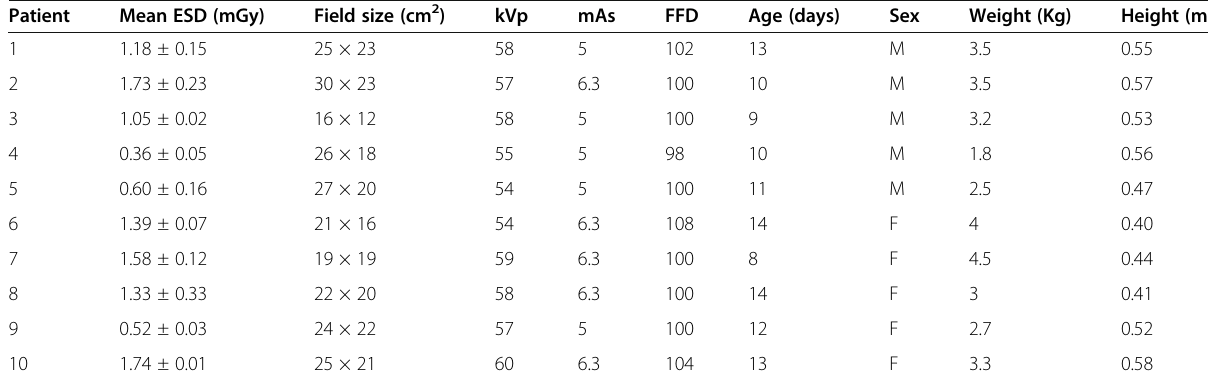
Table 3 Entrance surface dose (ESD) and other parameters for newborn between 8 and 14 days